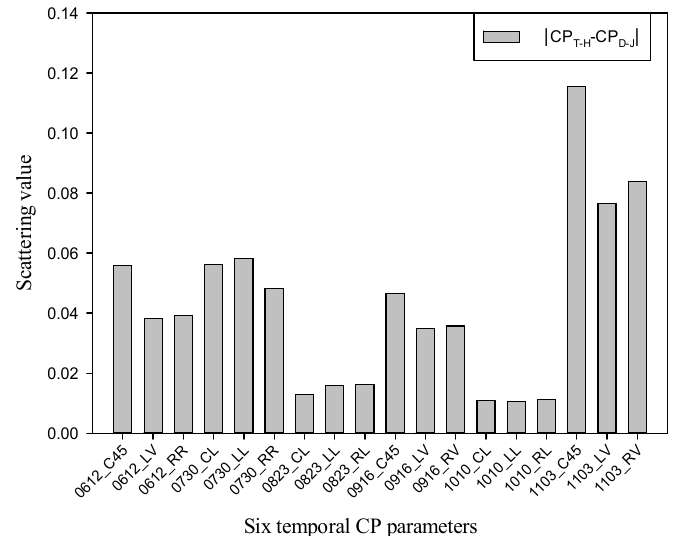
Figure 11. The histogram of the differences (|CP T–H − CP D–J |) in scattering intensities of the two types of rice paddies under the three modes under the six periods.